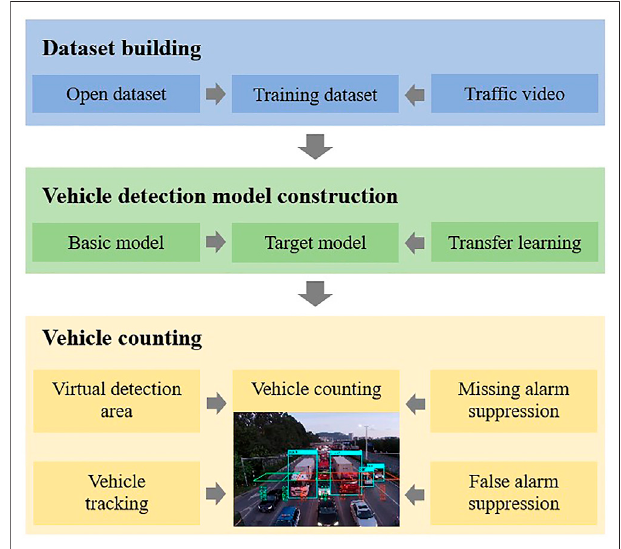
FIGURE 1 | Framework for video-based vehicle